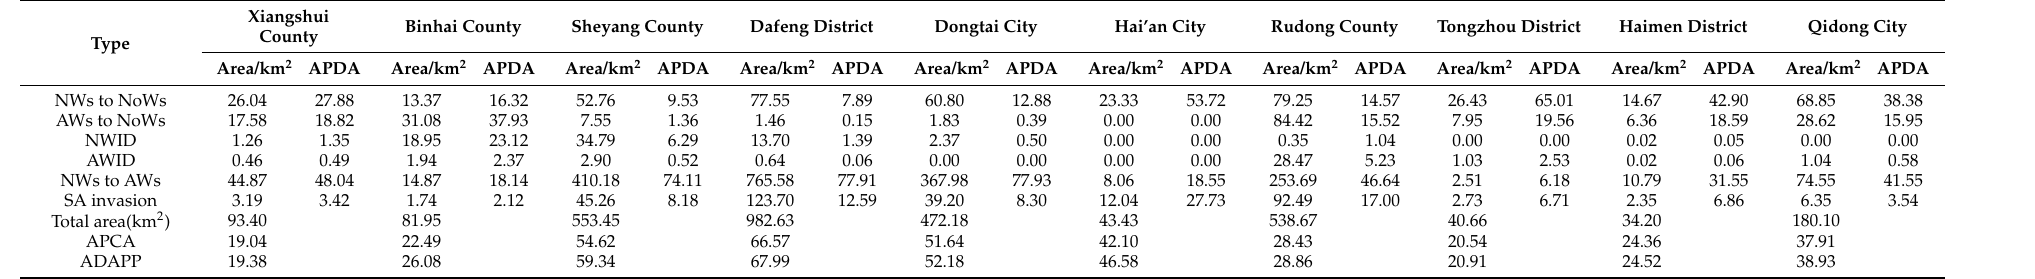
Table 4. Degradation in different administrative regions of the study area in